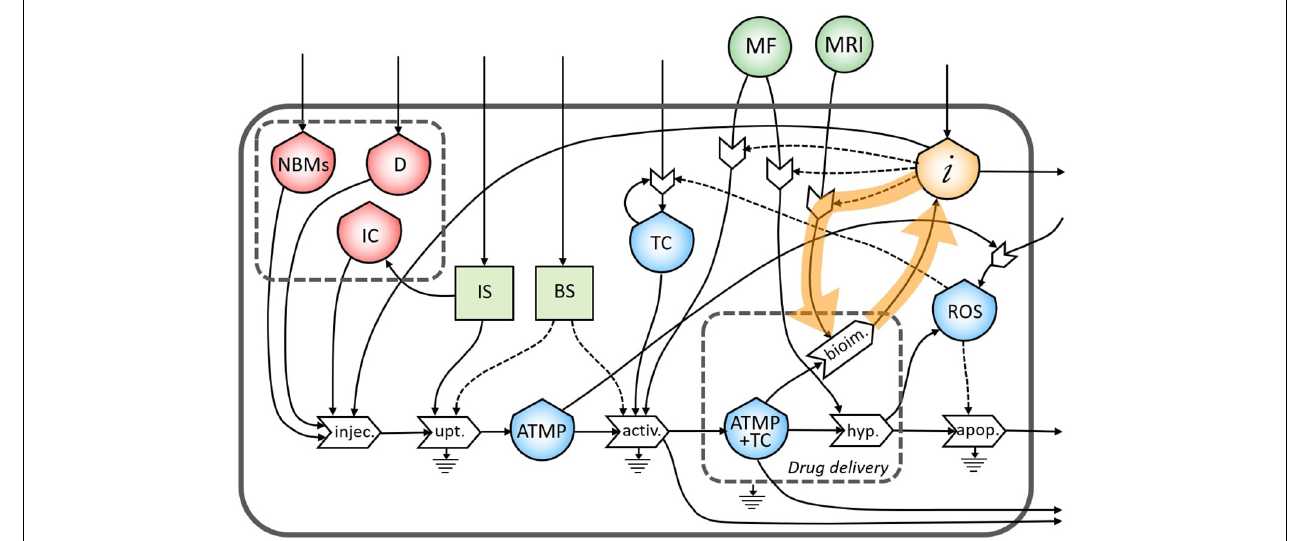
FIGURE 4 | Representation of the feedback loop of the flow of information on the bioimaging process.